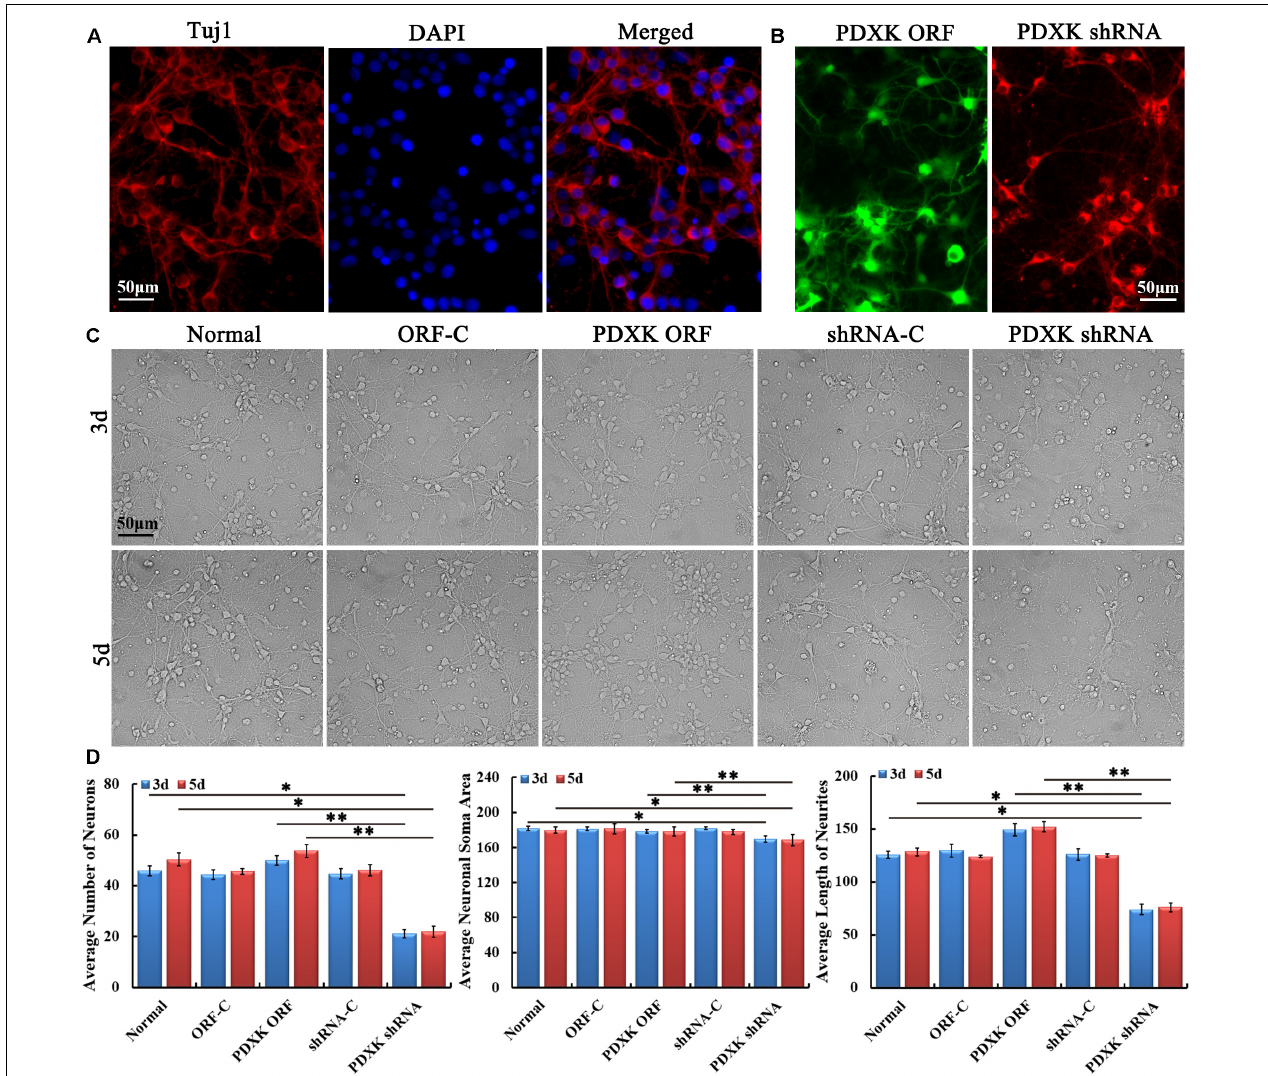
FIGURE 2 | Growth characteristics of primary cultured cortical neurons in rats after transfecting with PDXK-ORF/shRNA Lentivirus. (A) Tuj1 staining for cortical neurons at 7 days after culturing. Scale bar = 50 µ m. (B) PDXK ORF virus production carrying eGFP and PDXK shRNA virus production with mcherryFP were transfected into primary cortical neurons, respectively. Scale bar = 50 µ m. (C) Primary cultured cortical neurons were transfected with Lentivirus for 3 and 5 days. Scale bar = 50 µ m. (D) The number, soma size, and neurites’ length of cortical neurons were measured using Leica AF6000 system and quantified after transfected with Lentivirus for 3 and 5 days. Data were shown as mean ± SD. * P < 0.05, ** P < 0.01. eGFP, enhanced green fluorescent protein; PDXK, pyridoxal kinase; C,